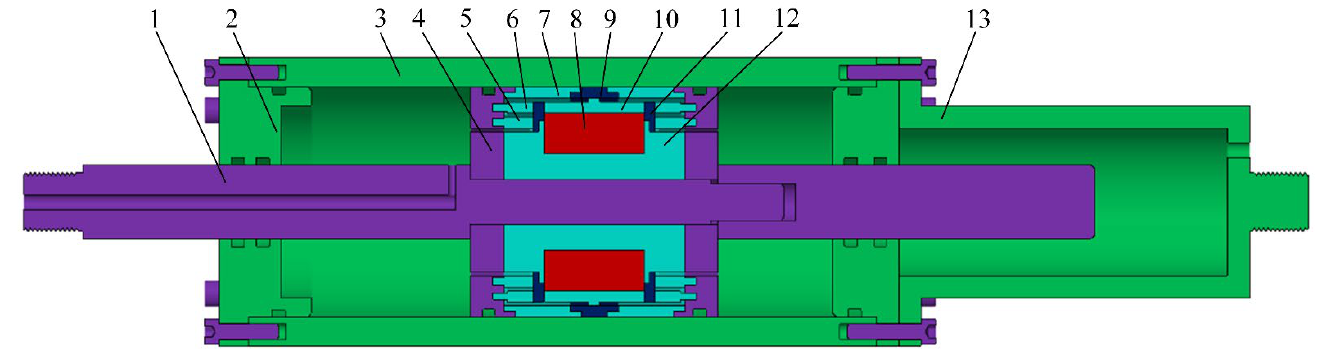
Figure 2. Schematic diagram of the MR damper with folded resistance gaps and bending magnetic circuit. 1. Piston rod, 2. End cover, 3. Cylinder, 4. Piston cover, 5. Inner magnetic sleeve, 6. Middle magnetic sleeve, 7. Outer magnetic sleeve. 8, Exciting coil, 9. Non-magnetic ring, 10. Magnetic semicircle, 11. Non-magnetic disk, 12. Magnetic core, 13. End shield.